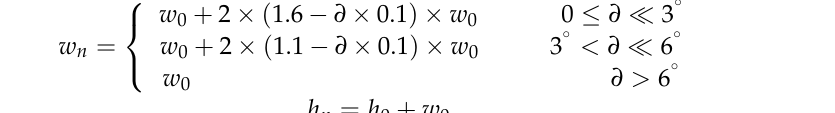
Figure 3. Expanding bounding box. ( a ) The structure of the pole; ( b ) Bounding box expansion; ( c ) Bounding box expanding to different values according to ∂ . In this case, the red line represents the original bounding box and the blue line represents the expanded bounding box. The left side is expanded by 0.51 w 0 and the right side by 1.33 w 0 in the width direction of the original bounding